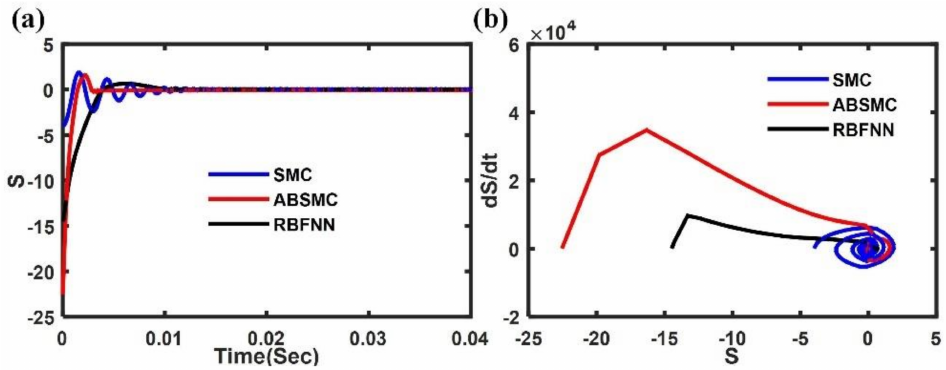
Figure 4. Current control transient response: ( a ) sliding manifold S; ( b ) S vs.